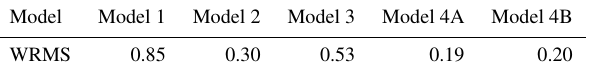
Figure 6. Trend of the Von Mises stress and cumulative displace- ment across the ATF (a–c) and GuF (b–d) fault zones after 10 years of tectonic extension and for the different adopted model settings. The cross sections cut the fault zones at 9km depth for ATF and 3km depth for GuF. FW-IR: footwall intact rocks; HW-IR: hanging wall intact rocks. The thick grey lines define the ATF and GuF fault zones. Table 2. Weighted root mean square (WRMS) calculations for dif- ferent models. In Model 1 all faults are locked; in Model 2 creeping is simulated only along the ATF considering a (5km) locking depth; in Model 3 creeping is simulated only along the GuF, whereas the ATF is considered locked; in Model 4A creeping behaviour is sim- ulated both along the ATF and GuF and finally in Model 4B multi- creeping layers are simulated in the ATF zone. The best fit is ob- tained for Model